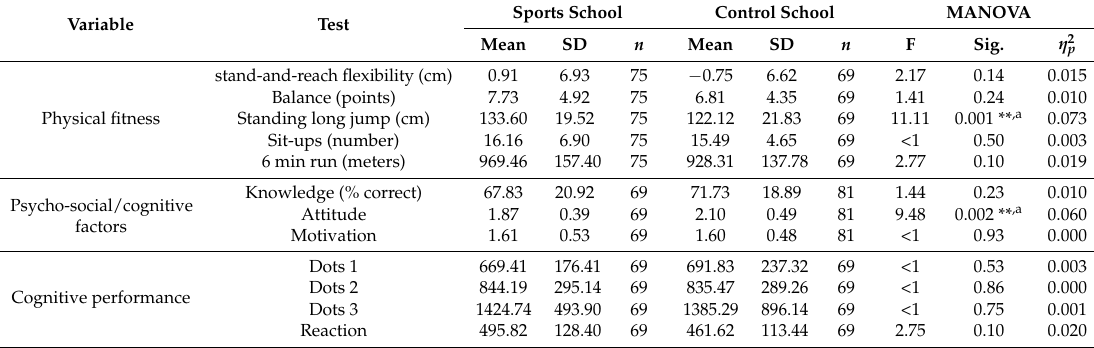
Table 2. Means and standard deviations of the two schools at T1 and corresponding between-group results of the respective multivariate analyses of variance (MANOVAs).